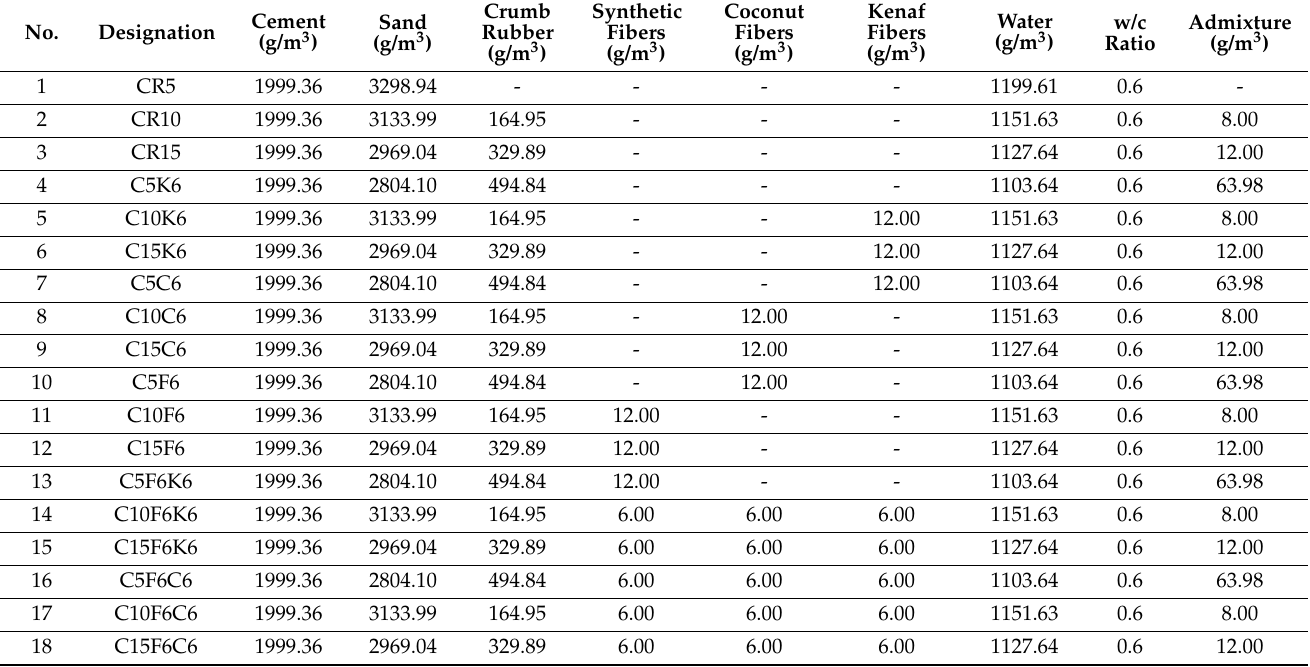
Table 2. Mix proportions for fiber-reinforced